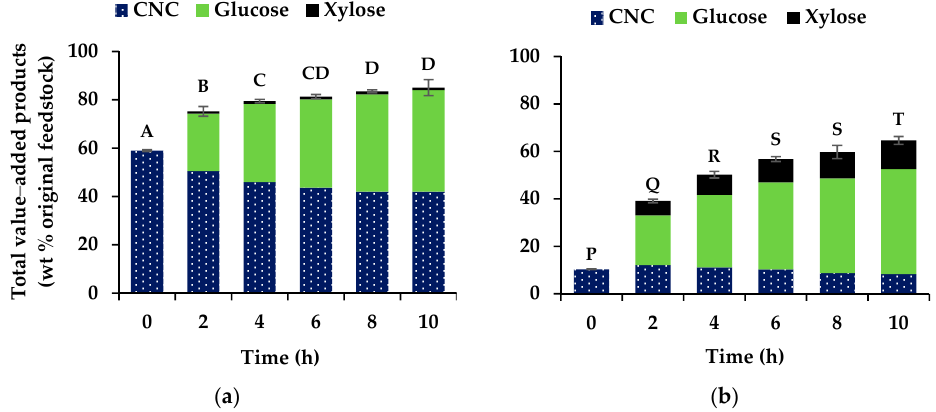
Figure 2. Total value-added products (CNC and sugars, wt % original feedstock) extracted from ( a ) filter paper and ( b ) wood pulp, via enzyme-mediated CNC production process. Error bars represent standard deviation of the total value-added products (wt % original feedstock). Bars that are denoted by non-identical letters are significantly different ( p < 0.05). Means and standard deviations for CNC yield from filter paper, cellulase cocktail treated for 10 h, were calculated from